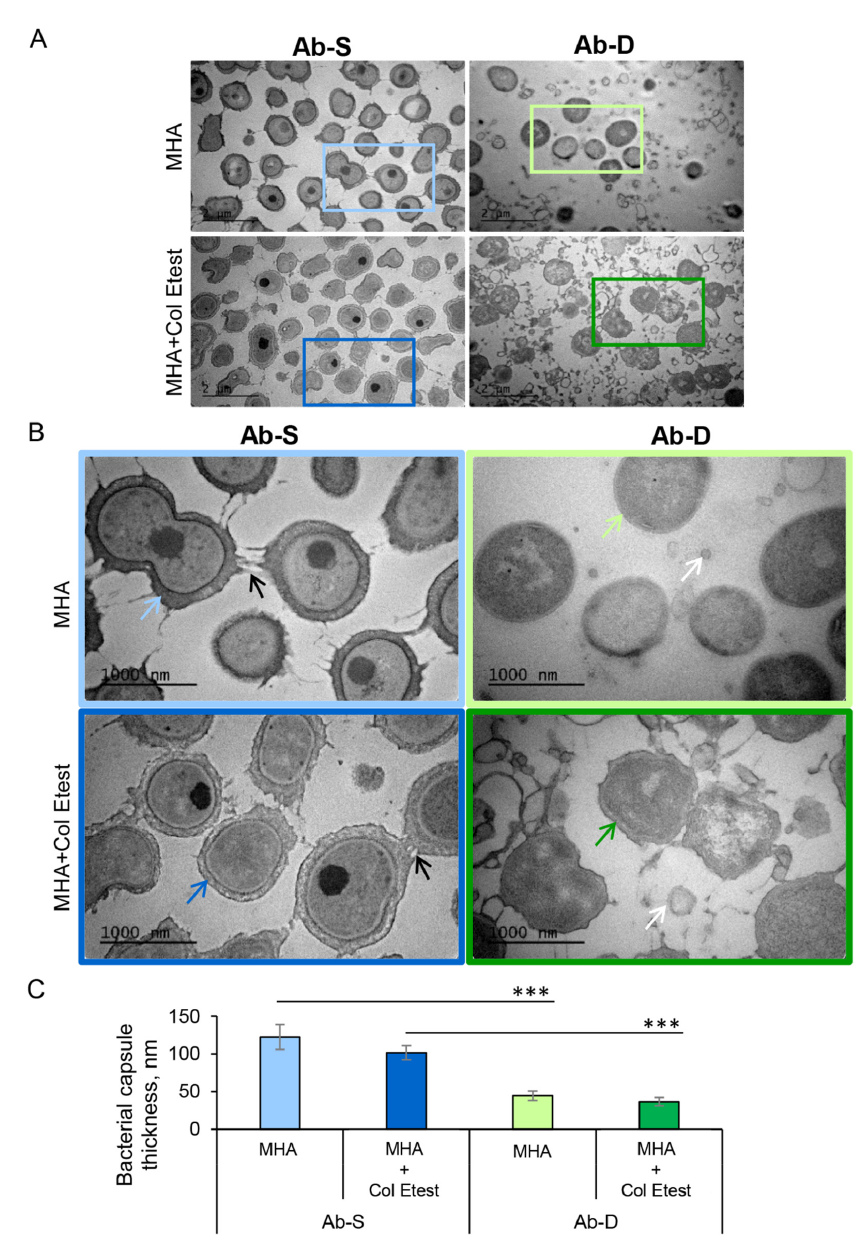
Figure 2. High-resolution visualization of A. baumannii populations and their capsular structure. Two A. baumannii populations, susceptible to colistin (Ab-S) and colistin-dependent (Ab-D) were grown on MHA plates (MHA) or MHA plates with colistin Etest strip (MHA + colistin Etest). Cells were collected, fixed, stained with uranyl acetate, and analyzed by TEM. The images are from one representative of three independent experiments. ( A ) Main panels, bars: 2 µ m. ( B ) Inserts, bars: 1000 µm. Black arrows point on appendage-like structures such as pili and fimbriae. White arrows specify outer membrane vesicles. Colored blue and green arrows point on exopolysaccharide capsule layers. ( C ) Quantification of the bacterial capsule thickness, nm. Columns represent the mean ± SE. Significant differences are indicated with *** when p > 0.001, as analyzed by two-tailed Student’s t -test. Data from three different experiments, and 100 different capsule areas in at least 50 different cells per condition were analyzed (same color code as in insert images).